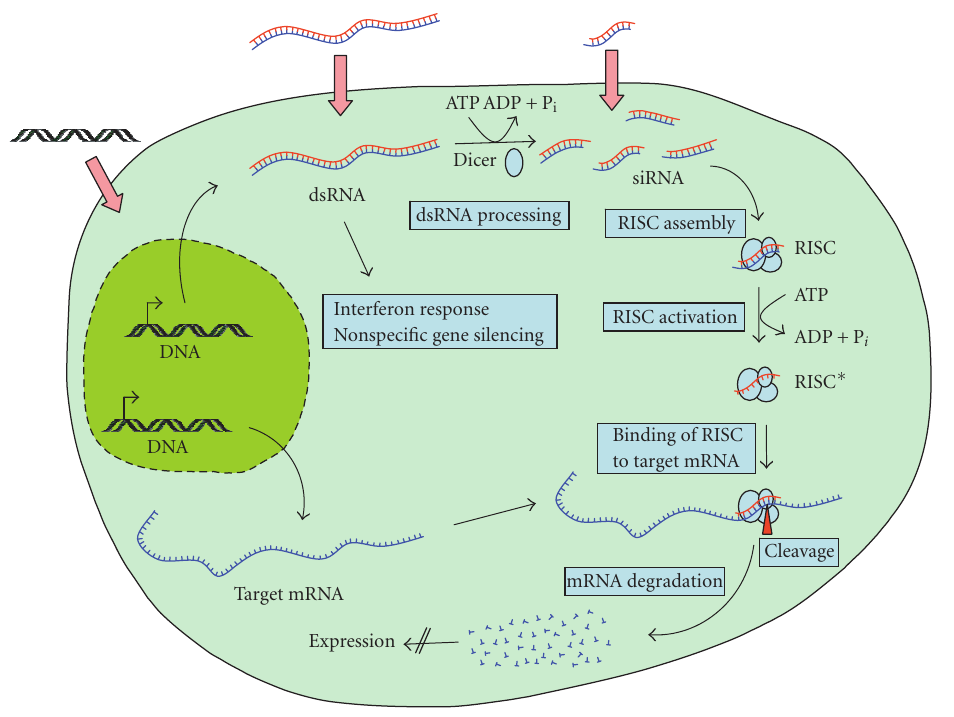
Figure 1: Mechanism of RNA interference (RNAi) in mammalian systems. Long double-stranded RNA molecules (dsRNA), which are expressed from DNA vectors (left red arrow) or directly enter the cell (center red arrow), are processed by the Dicer complex resulting in the formation of small inhibitory RNAs (siRNAs). Alternatively, to induce RNAi these small 21–23 bp duplexes are directly delivered into the cell (right red arrow). The siRNAs are incorporated into a nuclease-containing multiprotein complex called RISC, which becomes activated upon the ATP-dependent unwinding of the siRNA duplex by an RNA helicase. The now single-stranded siRNA guides the RISC complex to its complementary target mRNA which is then cleaved by the endonucleolytical activity of RISC. While the RISC complex is recovered for further cycles, the cleaved mRNA molecule is rapidly degraded due to its unprotected RNA